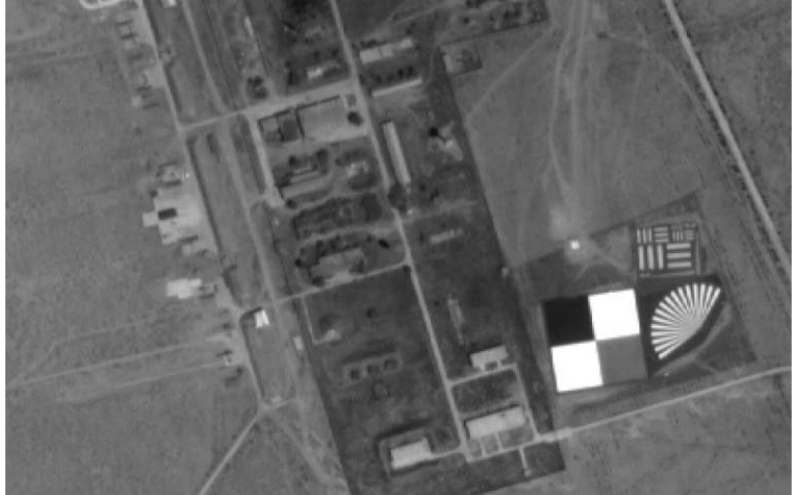
Figure 3. The gray-scale permanent artificial targets at RadCalNet Baotou site.